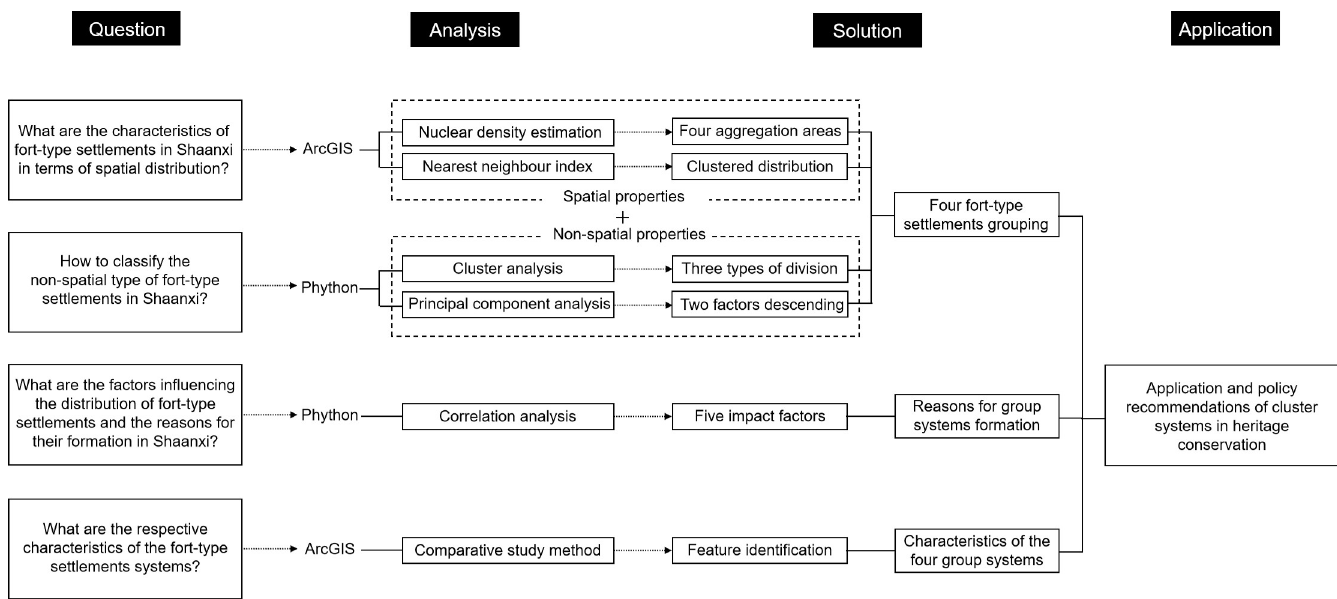
Fig 2. Research framework diagram.